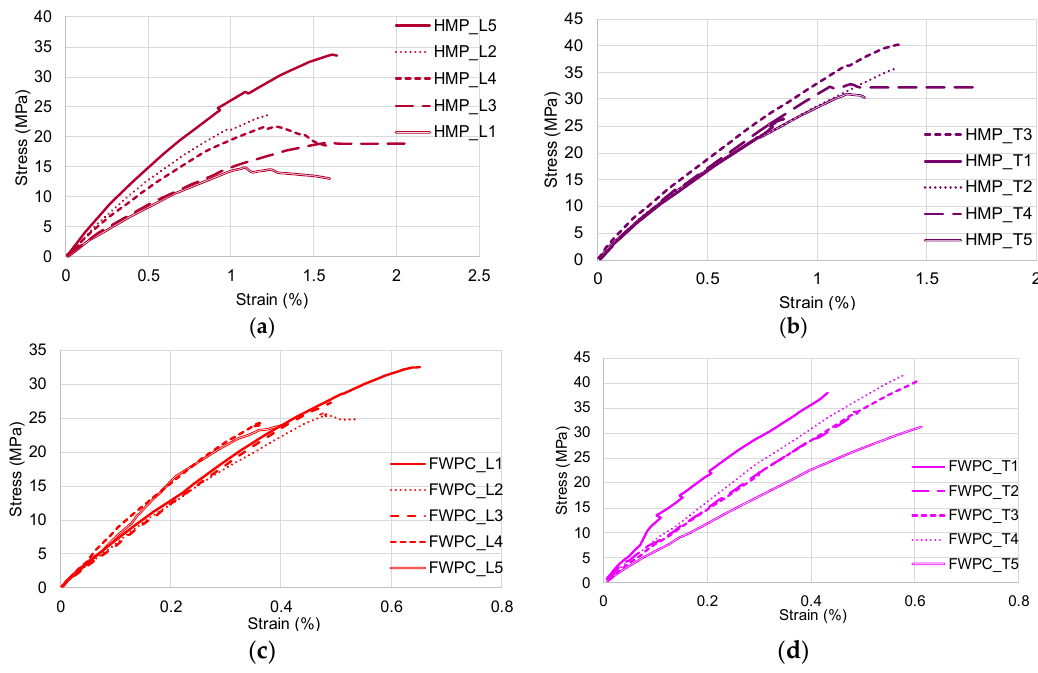
Figure 6. Characteristic curves stress–strain of natural fibres reinforced composites: ( a ) stress–strain curves for HMP_L samples; ( b ) stress–strain curves for HMP_T samples; ( c ) stress–strain curves for FWPC_L samples); ( d ) stress–strain curves for FWPC_T samples.